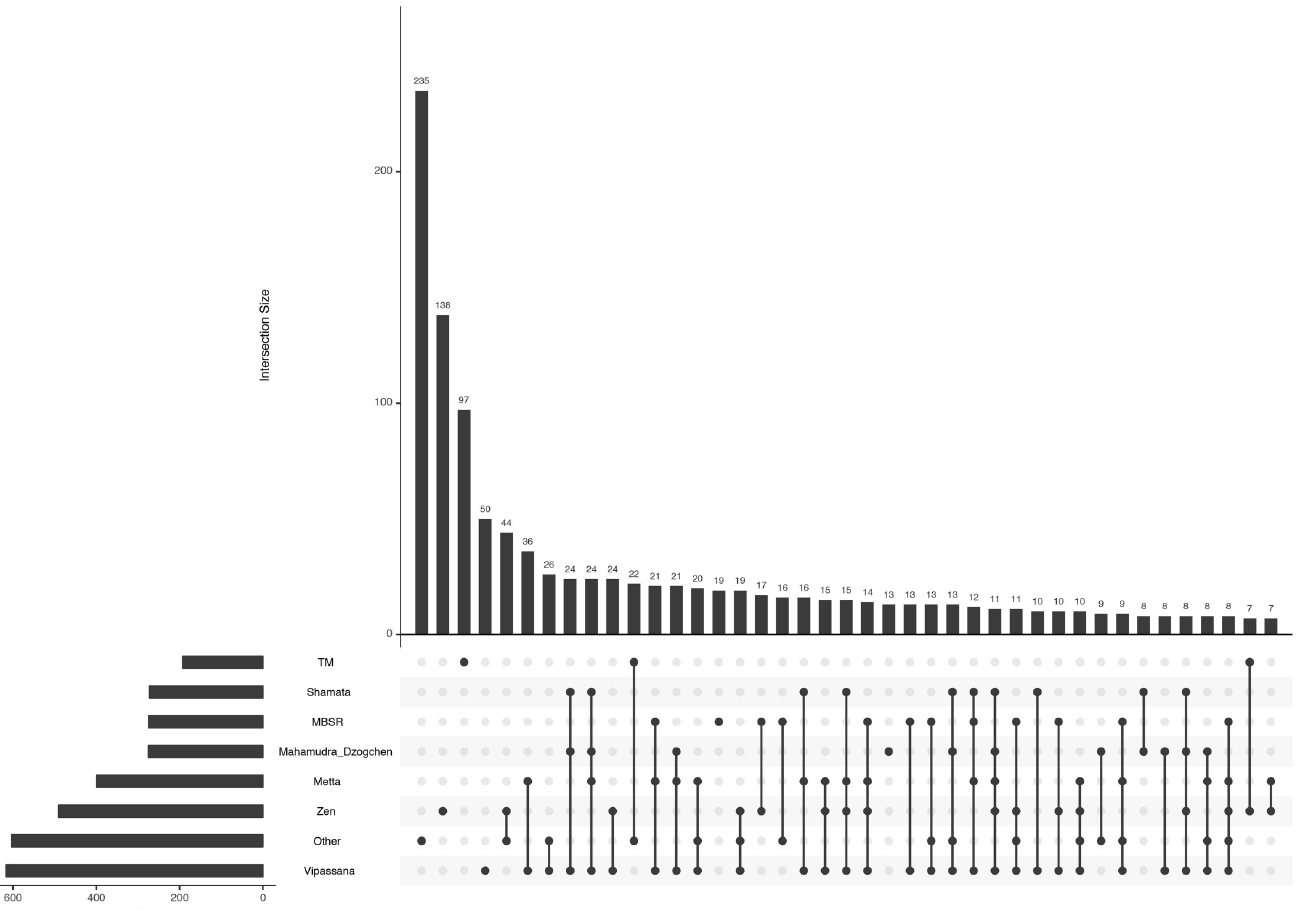
Fig 1. Combinations of meditation techniques. Upset plot showing the combinations of meditation techniques occurring in the analysis sample (N = 1403). The top graph is a histogram, with each bar representing the frequency of a particular (constellation of) meditation technique(s) that is/are identified right below it. Black dots connected by black lines string together meditation techniques that belong to a given constellation. The bar chart on the left shows the overall frequencies of each meditation technique.